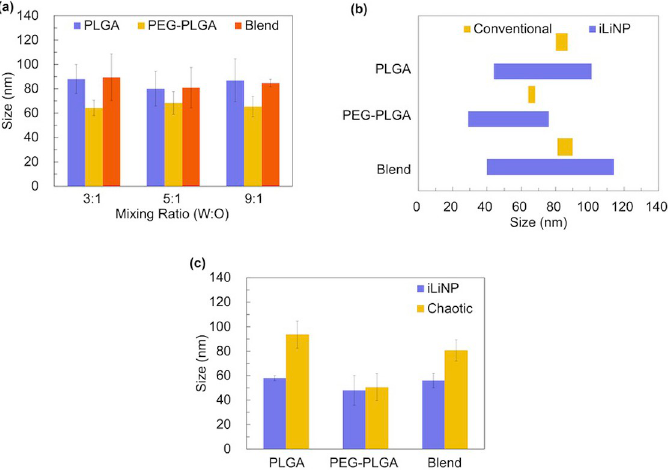
Fig 4. Comparison of NP sizes prepared using the iLiNP device, the chaotic mixer device, and the conventional method. (a) NP sizes prepared using the conventional method under different organic and aqueous solution ratios. The size range was: PLGA NPs: 80–87 nm; PEG-PLGA NPs: 64–68 nm; blend NPs: 81–90 nm; (b) Comparison of the particle size range of NPs prepared by the conventional method and the iLiNP device. (c) NP sizes prepared using the iLiNP device and the chaotic mixer device, NPs were prepared with FRR of 5 and TFR of 300 μ L/min. The error bars represent the standard deviations calculated from the repeated NP preparation experiment more than three times.